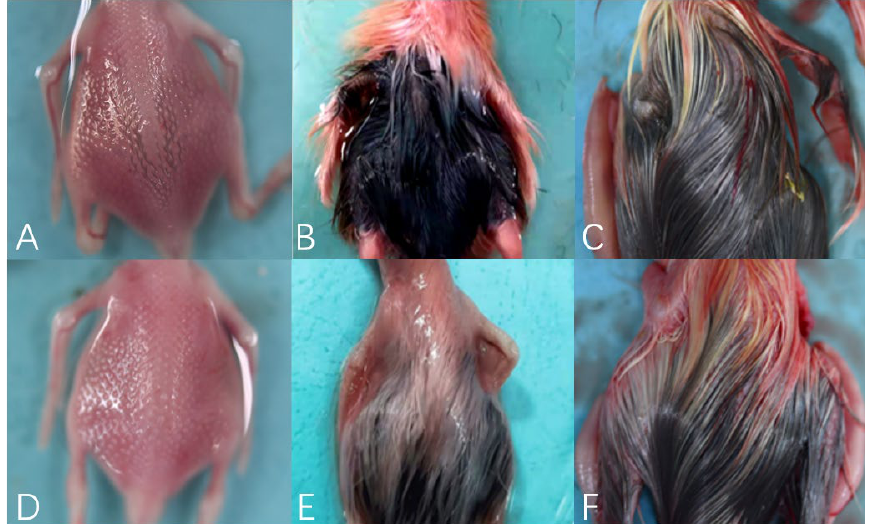
Figure 3. Visual observation of dorsal skin feathers development of Holdobaggy geese during embryonic stage. Note: ( A – C ). Visual observation of dorsal skin feathers development of female Holdobaggy geese embryos at E13, E18, and E28, respectively, and ( D – F ) Visual observation of dorsal skin feathers development of male Holdobaggy geese embryos at E13, E18, and E28, respectively. The dorsal feathers of geese embryos at E18 were keratinized. The feathers on the backs of male and female geese had a large area of obvious black, which started from the bottom of the feathers. The dorsal skins of geese embryos at E28 were completely covered by black and yellow feathers, and the dorsal feathers of male and female geese were lighter than those at